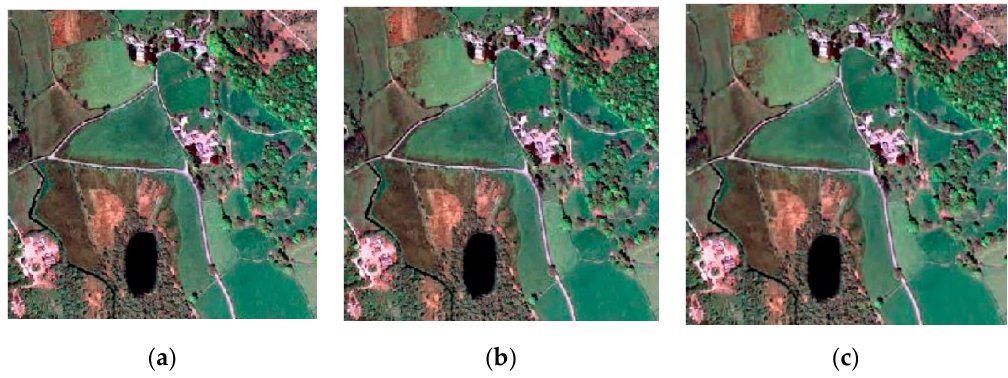
Figure 8. Three-channel image in pseudo-color representation: compressed with providing PSNR-HVS-M = 42 dB ( a ), compressed with providing PSNR-HVS-M = 36 dB ( b ); compressed with providing PSNR-HVS-M = 30 dB ( c ).